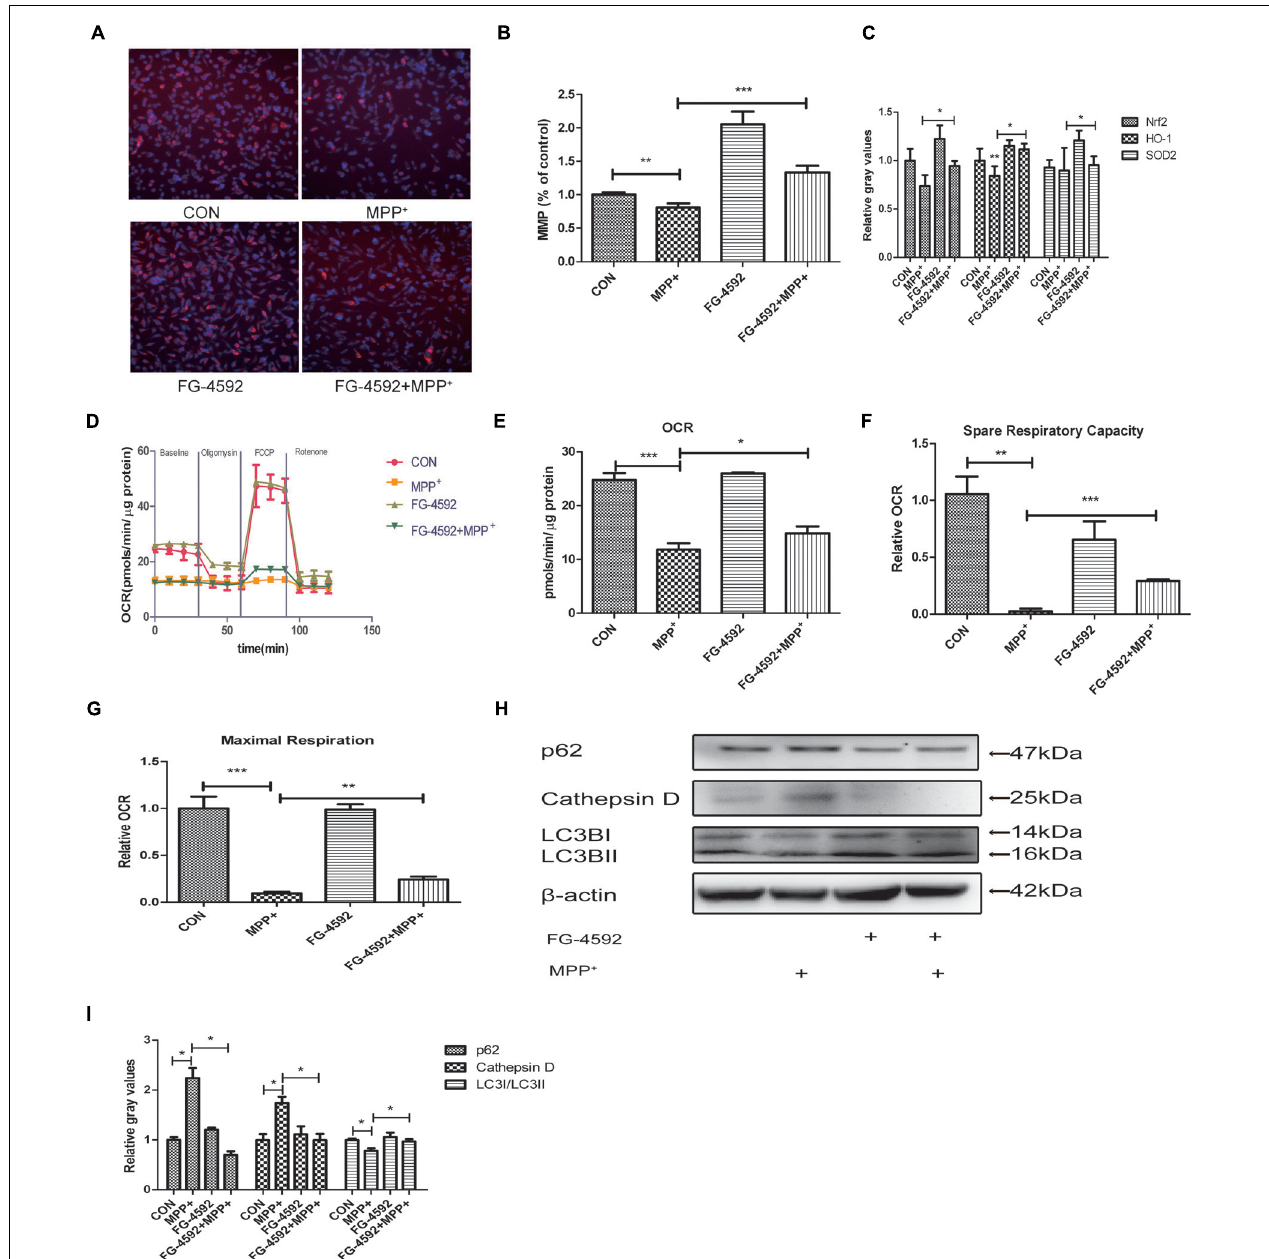
FIGURE 3 | Mitochondrial biogenesis and respiration are increased in dopaminergic neurons treated with FG-4592. SH-SY5Y cells were exposed to MPP + (3.5 mM) in the presence or absence of FG-4592 (50 µ M) for 24 h. Mitochondrial membrane potential (MMP) in cells was measured using the HCS (A,B) , red represents MMP and blue represents nuclei. ATP production (C) was detected by commercial kits as described in Methods. Mitochondrial oxygen consumption rate (OCR) in human dopaminergic neurons was measured using the Seahorse XFe24 analyzer as described (D) . We also list the OCR quantification (E) , Spare respiratory capacity (F) and Maximal respiration (G) . Western blotting analysis and quantification of the relative p62, Cathepsin D, LC3BI and LC3BII protein abundance in the cells were showed in (H,I) . β -protein served as the control. Data were expressed as means ± SD, ∗ P < 0.05, ∗∗ P < 0.01, ∗∗∗ P < 0.001 as compared to the control or MPP + ( n =